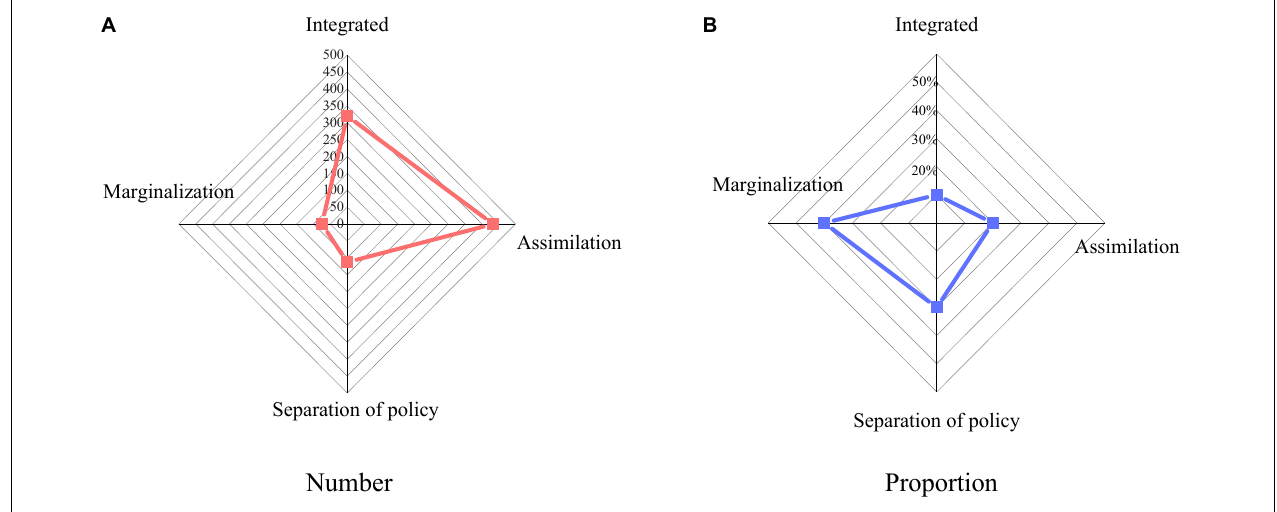
FIGURE 8 | Migrant childrens (MC’s) ways of cultural adaptation. (A) Number of Migrant childrens (MC’s) ways of cultural adaptation; (B) proportion of Migrant childrens (MC’s) ways of cultural adaptation.